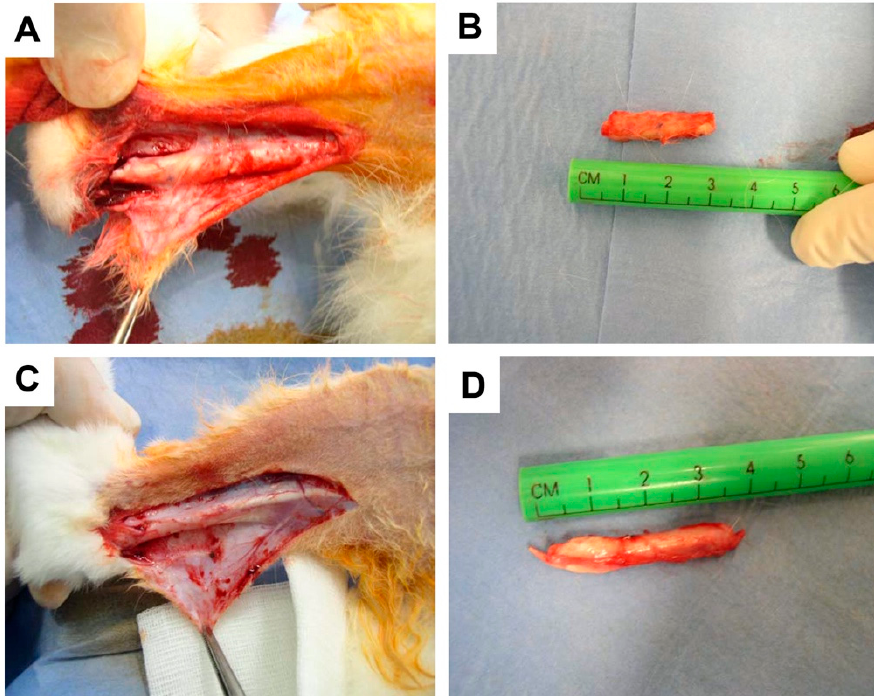
Figure 2. Macroscopic analysis of tendon adherences at time of explant. ( A , B ) Hyaloglide ® group. ( C , D ) Control unprotected group.